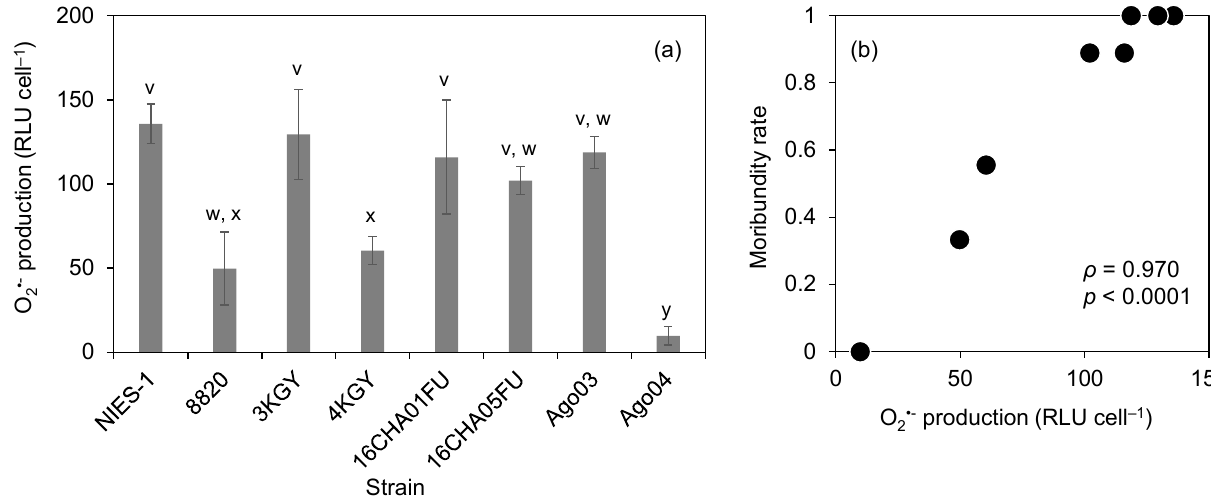
Figure 5. Superoxide (O 2• − ) production levels of Chattonella strains ( a ) and their relationship with the moribundity rate shown in Figure 2. Data of control (no Chattonella cell) are also plotted ( b ). Each bar represents the mean ± SD of triplicate measurements. Means that are not significantly different are labeled with the same letter (v–y; p < 0.05). RLU, relative luminescence units.